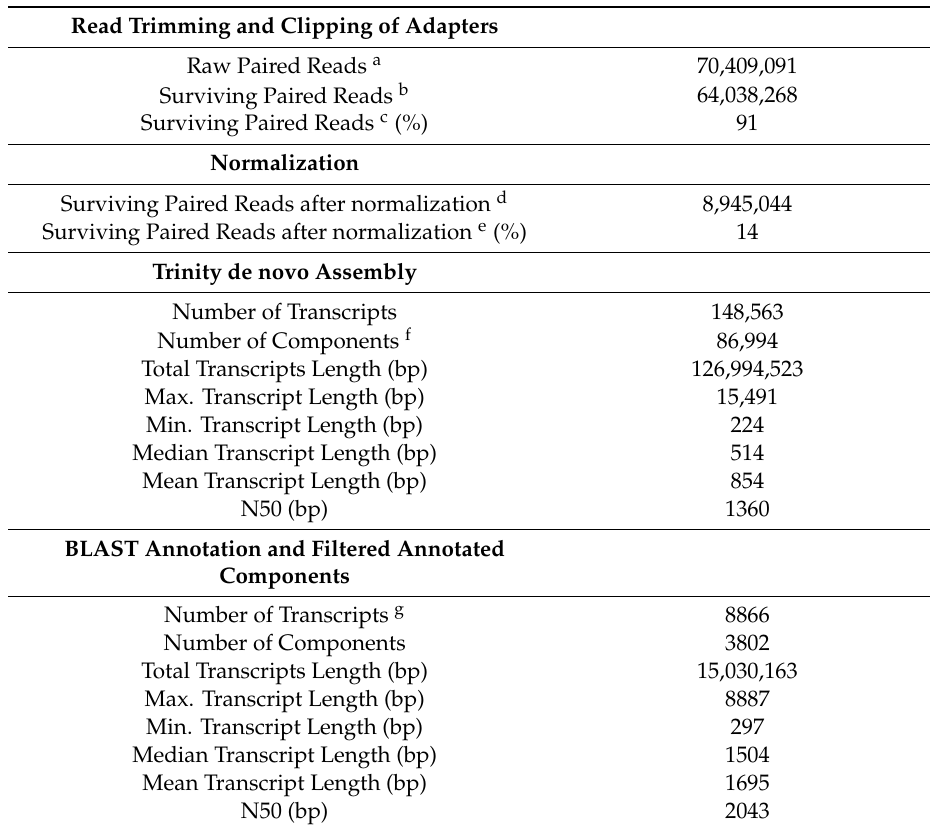
Table A5. Values pertaining to the RNA-Seq output, its trimming and assembly and the transcript length